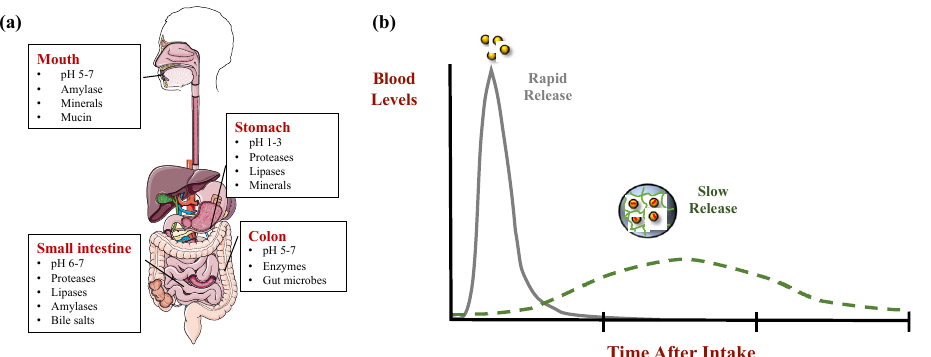
Figure 3. ( a ) Illustration of the environmental conditions in the gastrointestinal tract; ( b ) Rapid- and slow-release patterns of encapsulated bioactives.